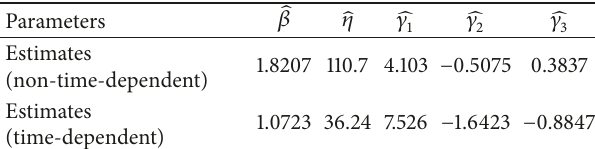
Table 4: Parameter estimation of WPHM.